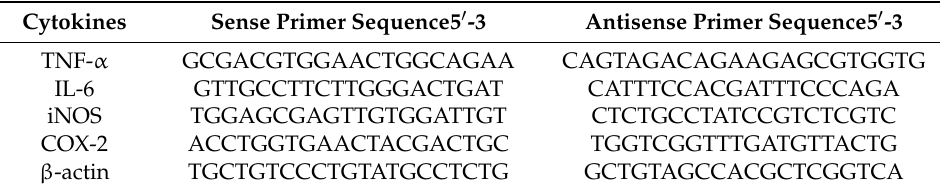
Table 2. The primers used for RT-PCR